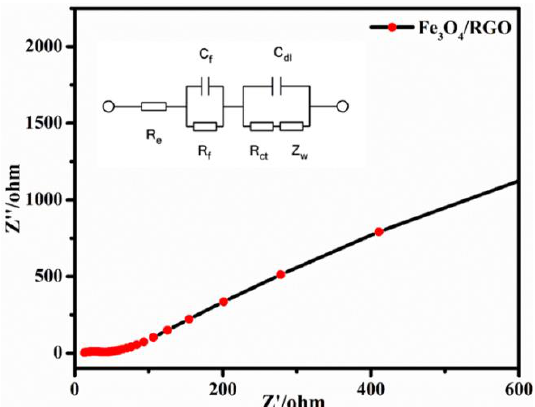
Figure 8. Nyquist plot relating to Fe 3 O 4 /RGO composite electrode after 5 cycles at a current density (200 mA/g). Inset: equivalent circuit used to discuss the data. R e : electrolyte resistance, R ct : charge transfer resistance, C dl : double layer capacitance, Z w : Warburg element.